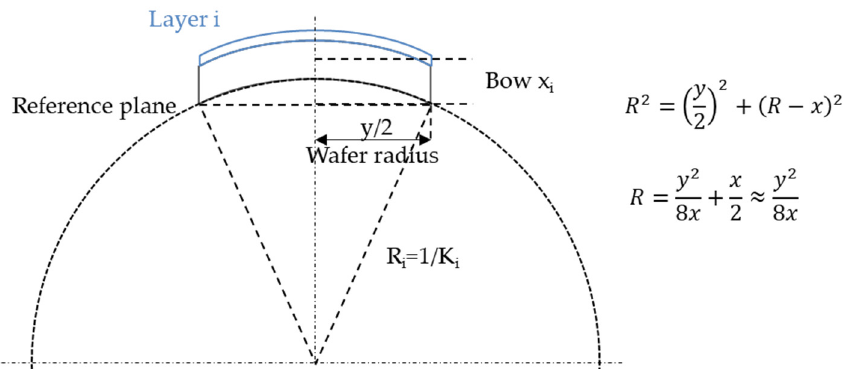
Figure 3. Relation between curvature radius and sagitta, or bow, of a wafer.